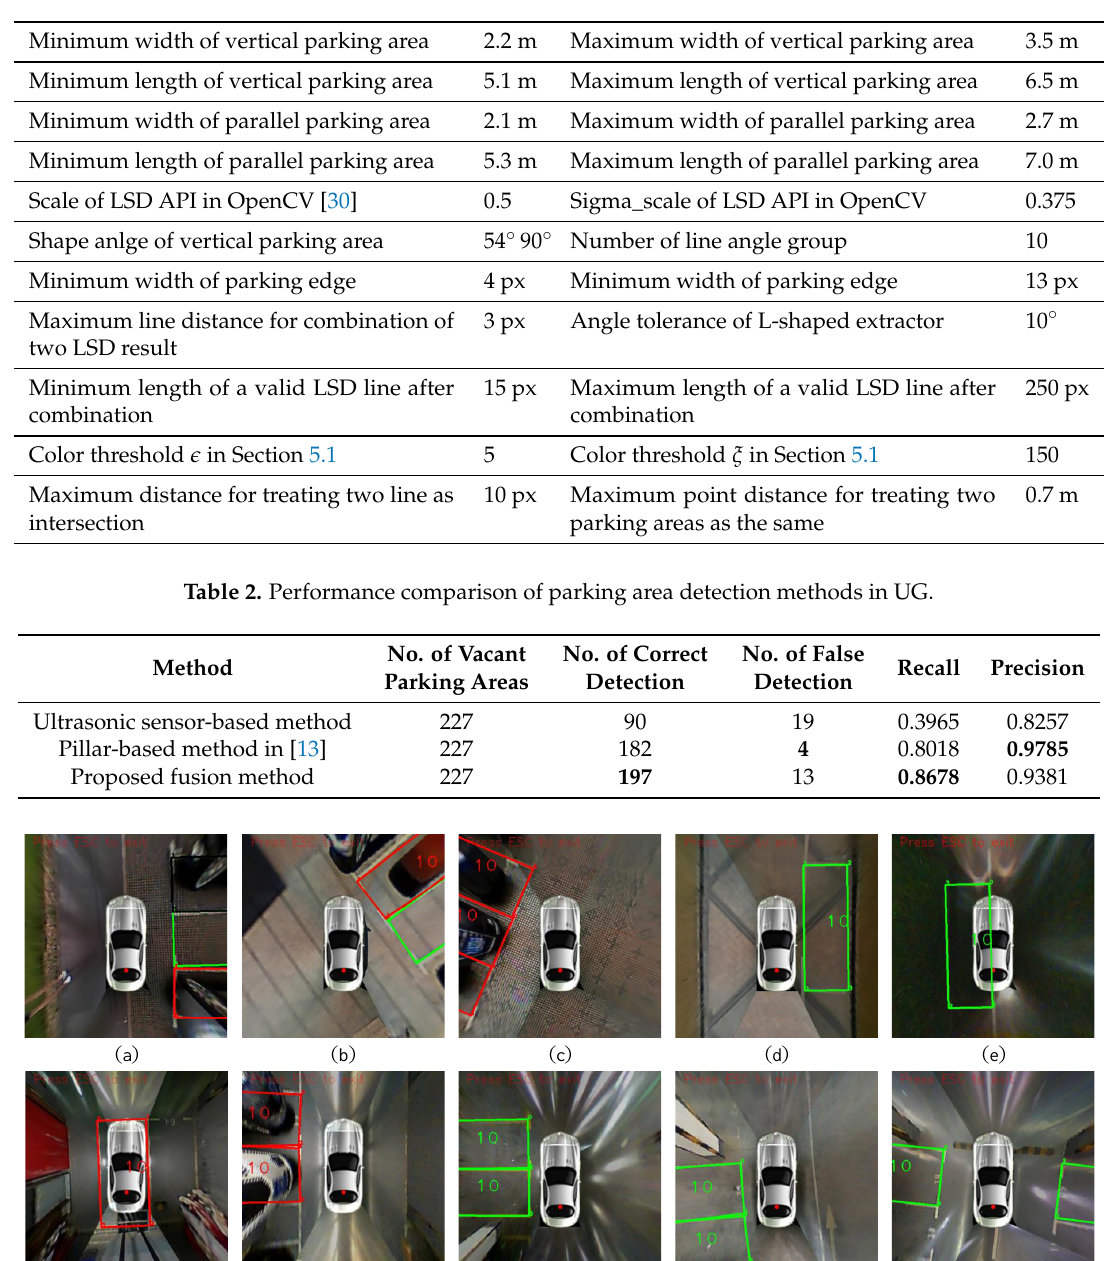
Table 1. Parameters chosen for the experiments.